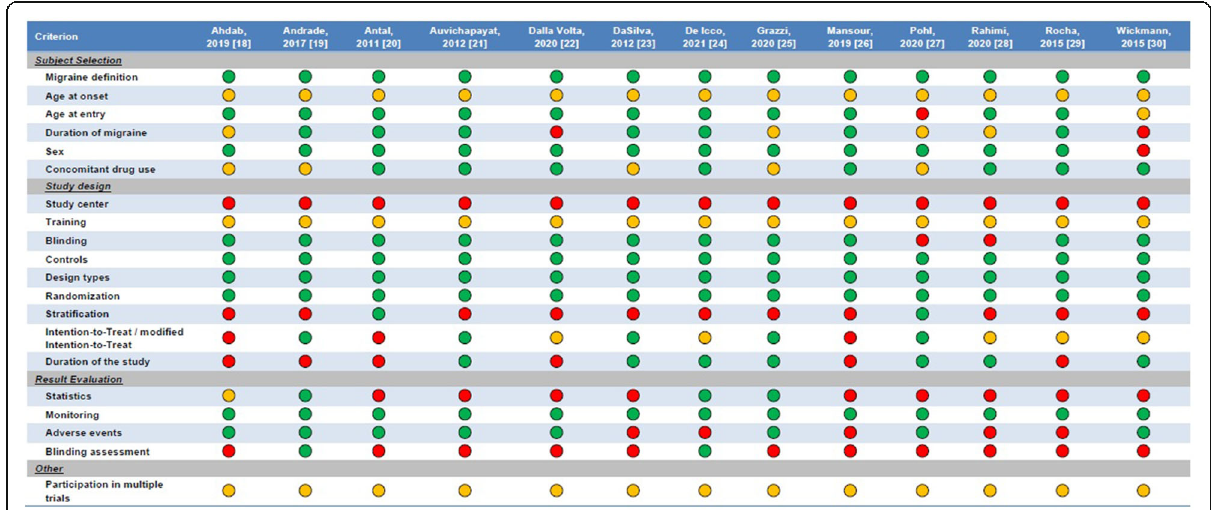
Fig. 4 Adherence of available randomized controlled trials on transcranial direct current stimulation to the guideline recommendations for clinical